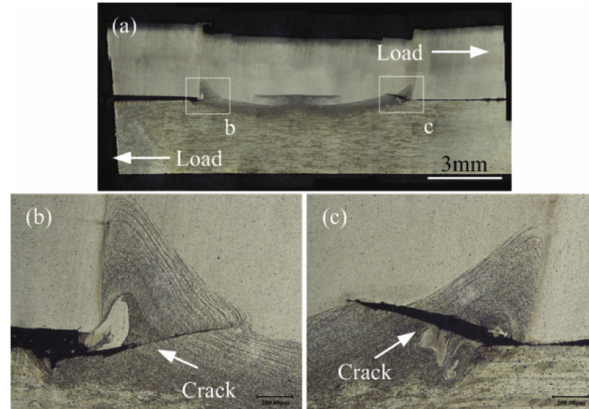
Figure 9: Fracture position of the joint: (a) general view, (b) and (c) magnified views of the fracture